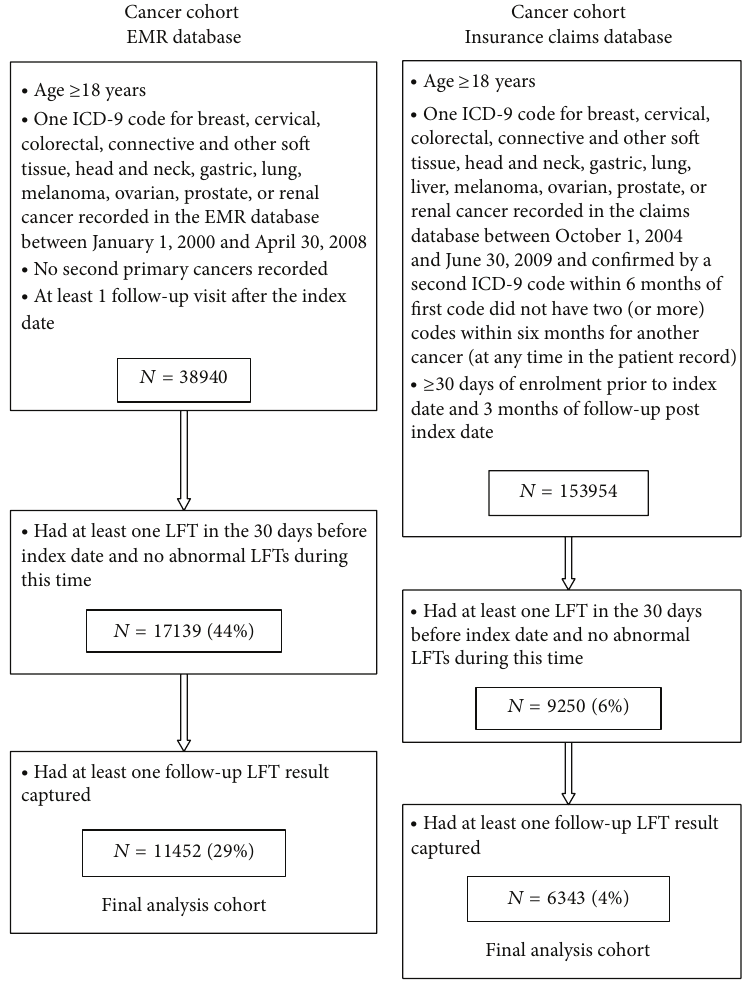
Figure 1: Cohort selection, cancer